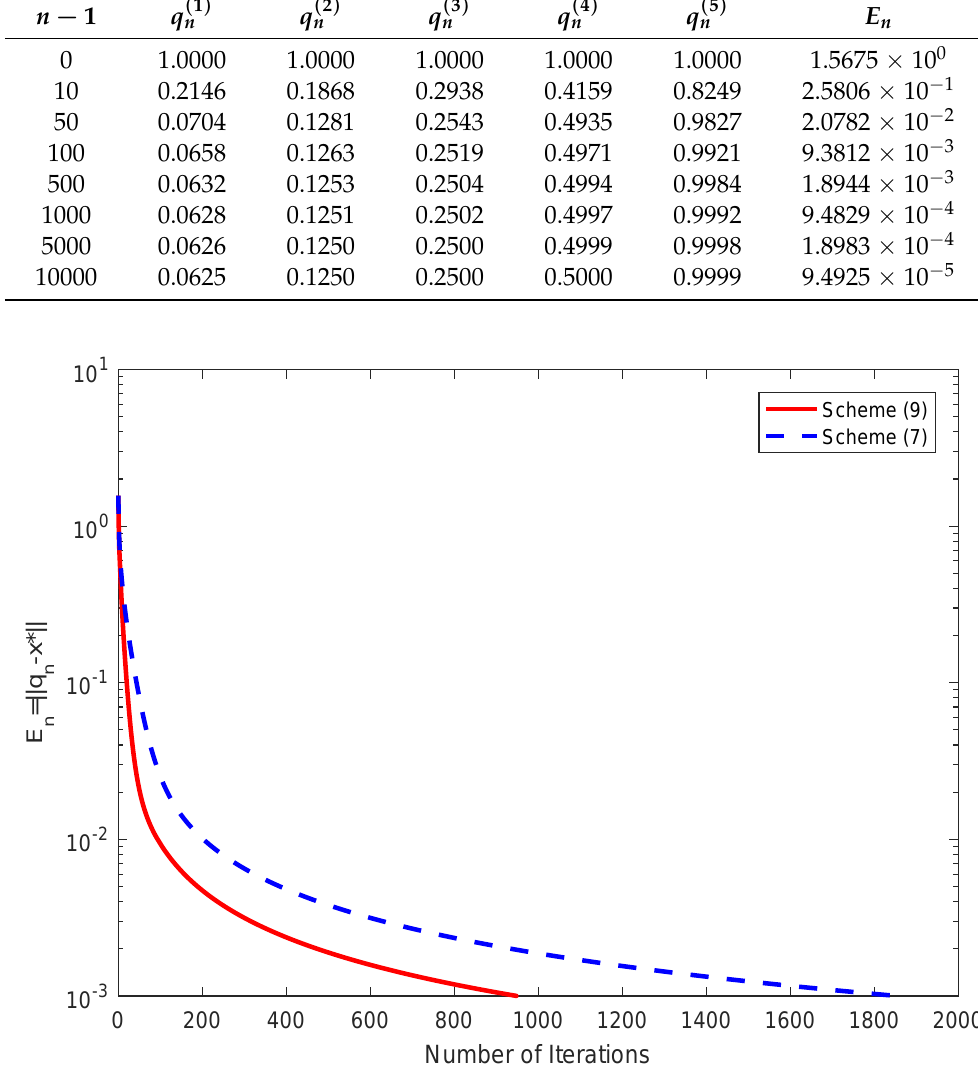
Figure 1. Comparison of scheme (9) and scheme (7) in Example